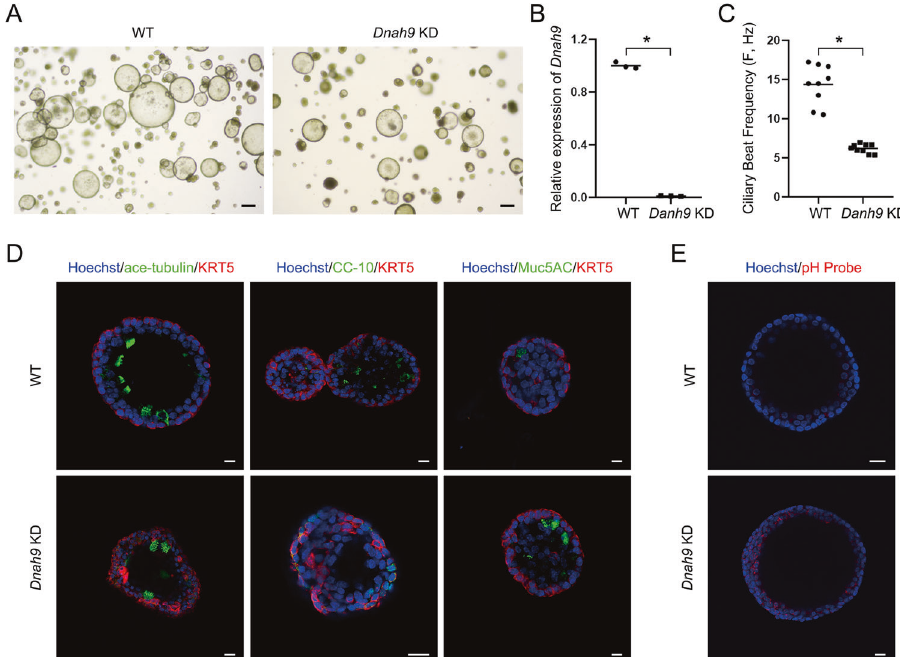
organoid relative to WT. * P < 0.05; n = 3 per group. C CBF of Dnah9 KD group was signi fi cantly lower than WT group. * P < 0.05. n = 10 per group. D Whole-mount mouse airway organoid immuno fl uorescence shows markers for basal cells (KRT5, red), ciliated cells (acetylated a- tubulin, green), club cells (CC-10, green) and goblet cells (MUC5AC, green). Scale bar = 10 µm. E Confocal microscopy images of mouse airway organoid with a pH probe show lower pH value in the Dnah9 KD group than WT. The stronger red color indicates lower pH value in the epithelial cell of the Dnah9 KD group. Scale bar = 10